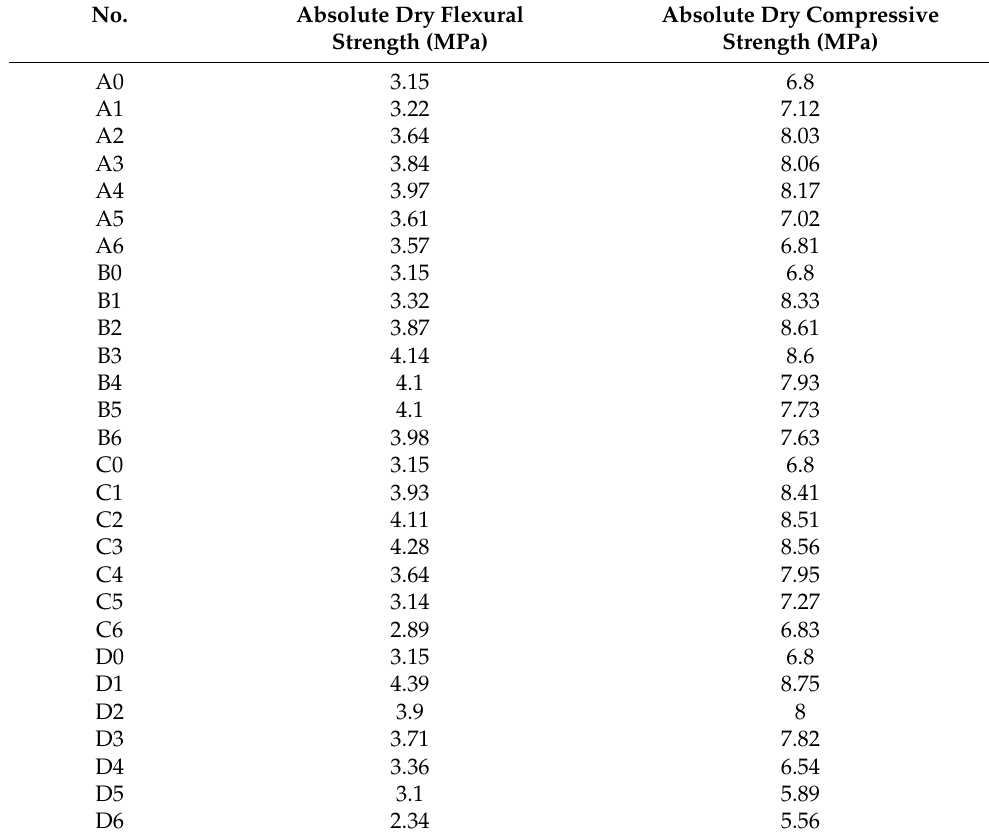
Table 3. Effects of different ball-milling parameters on the strength of phosphorus building gypsum. No.